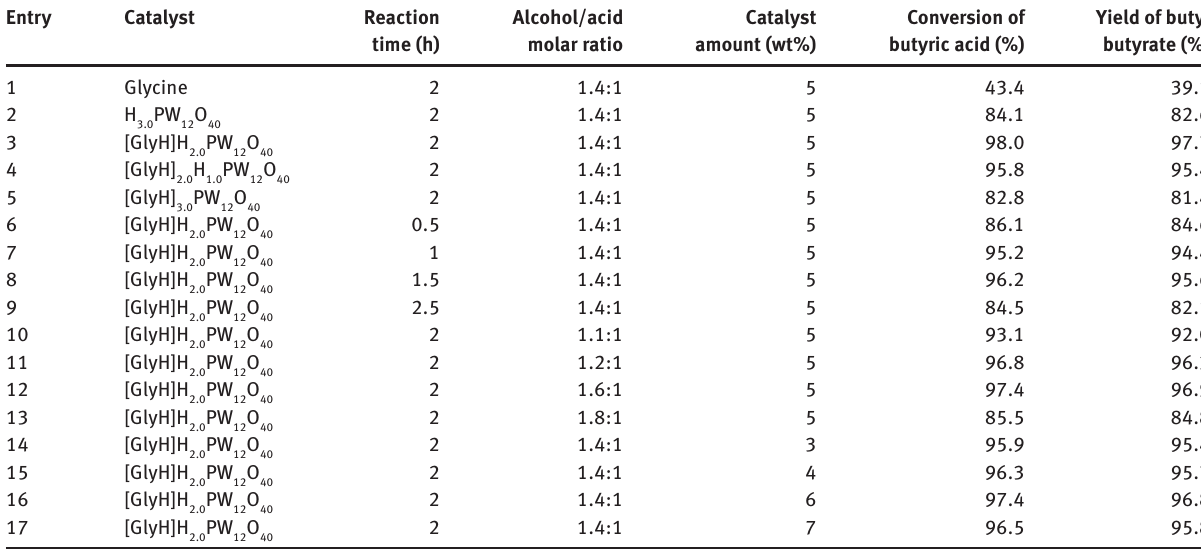
H PW O under different conditions. 1.0 2.0 12 40